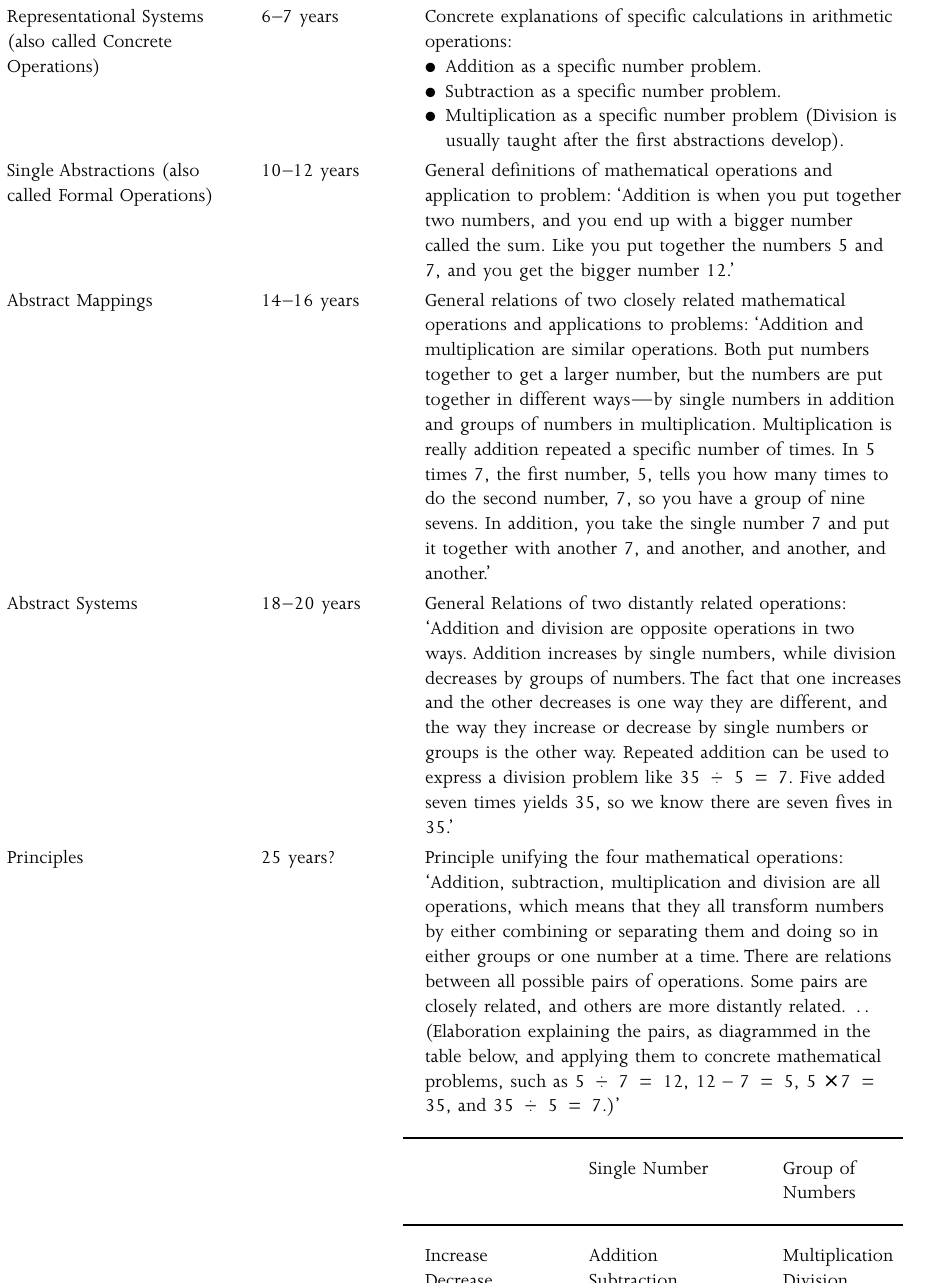
Table 1 Examples of mathematical skills for five cognitive developmental levels Level Age of